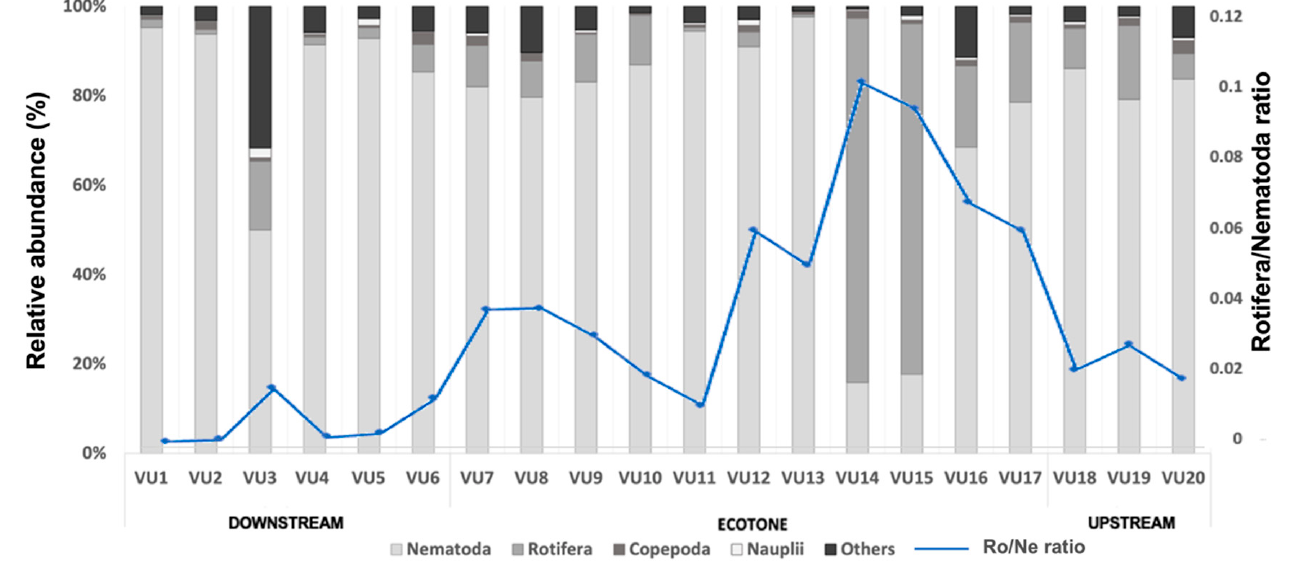
Figure 5. Proportional composition of meiofauna and Rotifera/Nematoda ratio along the Van Uc River.